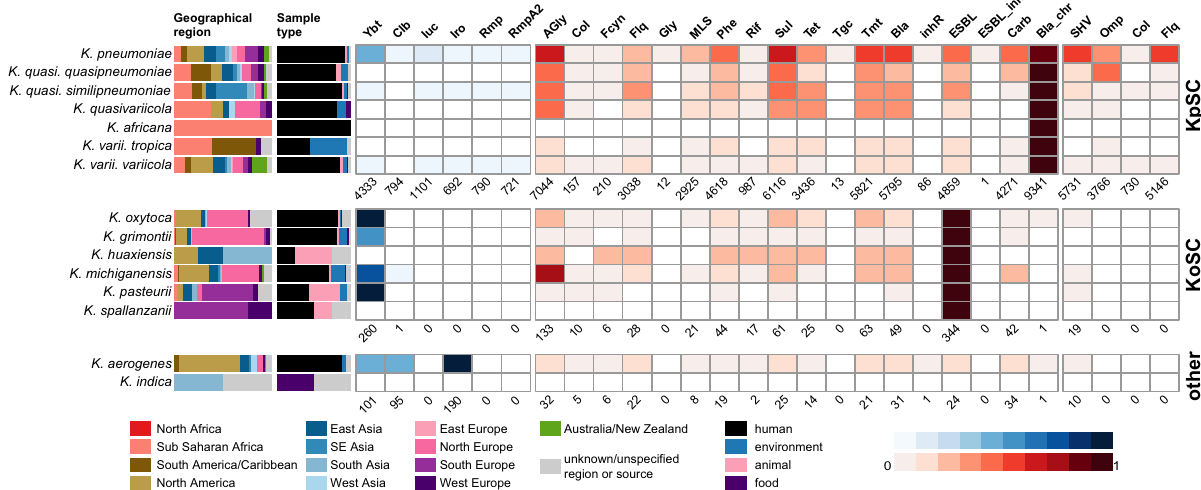
Fig. 4 Summary of genome collection metadata, and Kleborate-derived virulence and antimicrobial resistance (AMR) genotypes, for all publicly available Klebsiella genomes. Data shown summarize Kleborate results for 11,277 non-redundant Klebsiella genomes publicly available as at 17 July 2020 (Supplementary Data 2). From left to right: barplots showing source information by geographical region and sample type (coloured as per inset legend); heatmaps showing the prevalence of virulence loci (blue) and predicted AMR drug classes (red) (as per inset scale bars). Genomes are summarized by species, ordered by species complex: KpSC, K. pneumoniae species complex; KoSC, K. oxytoca species complex; and other Klebsiella . In the heatmaps, the total number of genomes in which each type of virulence/AMR determinant was detected are indicated below each column. Column names are as